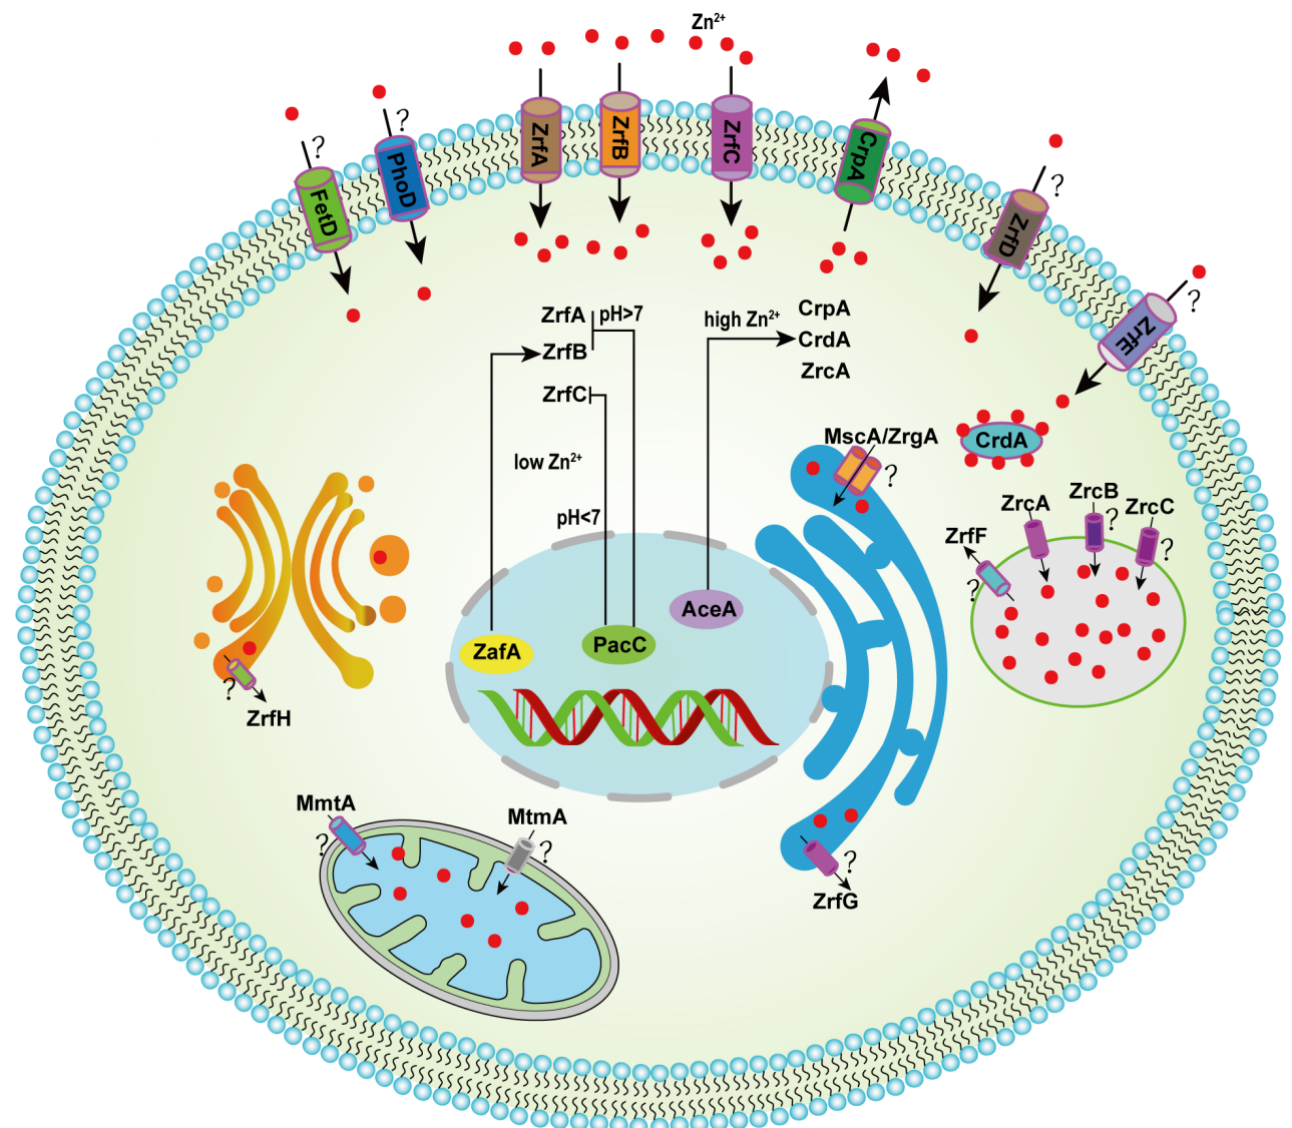
Figure 1. Hypothetical model for the homeostatic mechanism of zinc in A. fumigatus . Under acidic pH conditions, zinc enters the cytoplasm from the environment mainly through uptake by the transporters ZrfA and ZrfB, and under neutral to alkaline conditions, zinc enters the cytoplasm mainly through uptake by the transporter ZrfC. The transcription factor ZafA induced the expression of ZrfA, ZrfB and ZrfC in low-zinc conditions, and PacC suppressed ZrfA/B under alkaline conditions and ZrfC under acidic pH. Transcription factor AceA, under high-Zn conditions, induces the expression of CrpA, CrdA and ZrcA, which are transported to the extracellular space and vacuoles, respectively. The symbol “ ? ” indicates unexplored functions of the gene involved in zinc homeostasis.